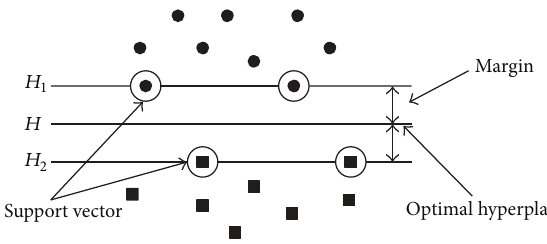
Figure 1: Support vector machine.